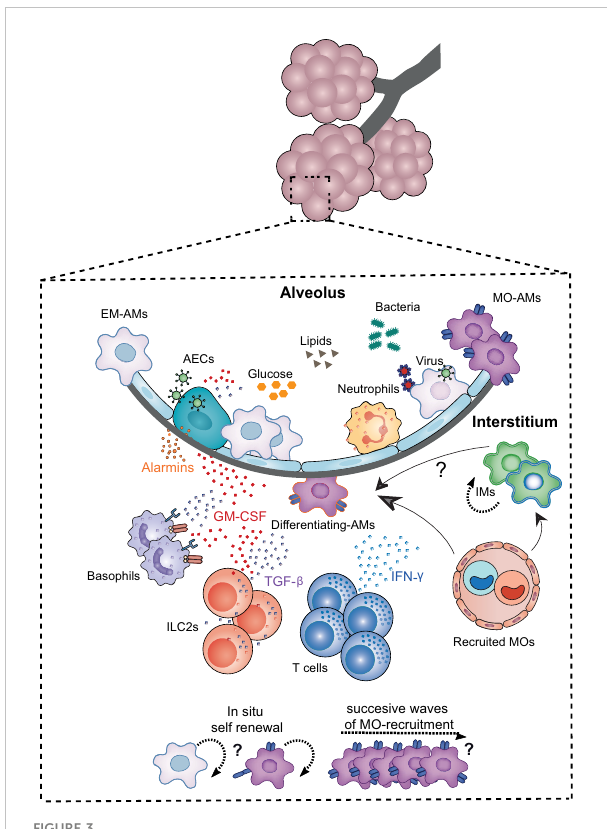
FIGURE 3 Niche microenvironment is a major determinant governing AM development, proliferation and activation. The developmental dynamics of AMs and their plasticity are intimately linked to signals from the local environment. The alveolar niche, in addition to supplying the structural scaffold necessary for the development of AMs, harbours key cellular actors that provide the trophic factors determining the differentiation, maturation, proliferation or functional polarisation of these cells. Among the niche cells identi fi ed in the steady state , alveolar epithelial cells (AECs), innate lymphoid cells type 2 (ILC2s), and basophils imprint AM identity and function, both at birth and throughout life, notably via the secretion of GM-CSF. TGF- b . Upon lung infection , the EM-AM population is partially depleted making the alveolar niche more accessible to BM- MO in fi ltration and differentiation into AMs in a similar GM-CSF and TGF-B-depend manner. The contribution of MOS to the AM pool is highly dependent on the type of in fl ammation, the extent of depletion, the turnover rate of AMs and IMs in the lung, and the presence of other imprinted niche cells such as altered ILC2s and/or tissue-resident T cells. In particular, the combination of chemokines and cytokines such as IFN- g released during in fl ammation, and the altered availability of trophic factors and nutrients may determine the differentiation of MOs into AMs, their polarisation as well as their renewal